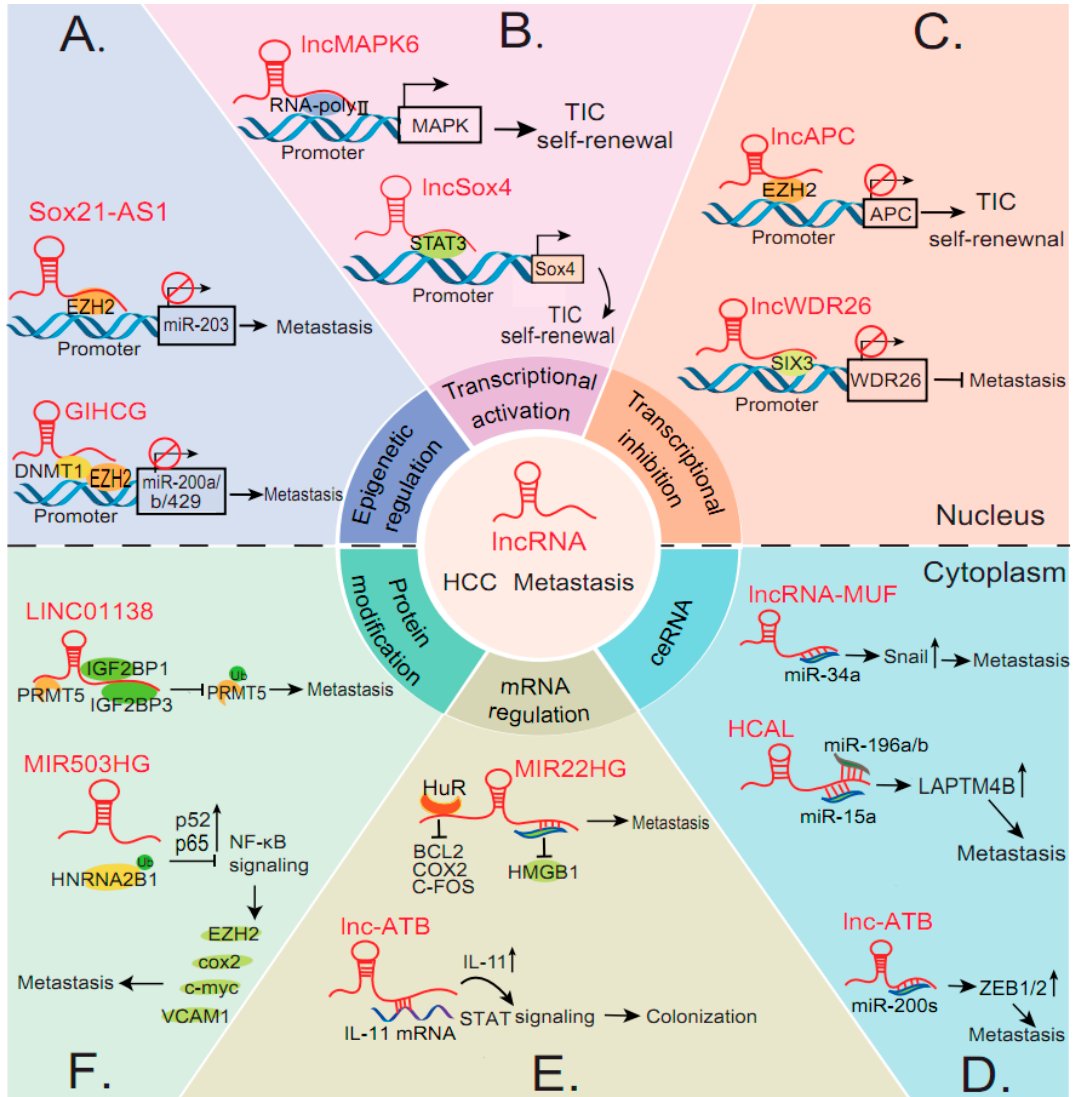
Figure 1. LncRNAs regulate hepatocellular carcinoma metastasis at different molecular levels. Figure1. LncRNAsregulatehepatocellularcarcinomametastasisatdi ff erentmolecularlevels. LncRNAs LncRNAs play a pivotal role in gene regulation and exert their effects in hepatocellular carcinoma play a pivotal role in gene regulation and exert their e ff ects in hepatocellular carcinoma metastasis through diverse mechanisms, including ( A ) epigenetic modification, ( B , C ) transcriptional